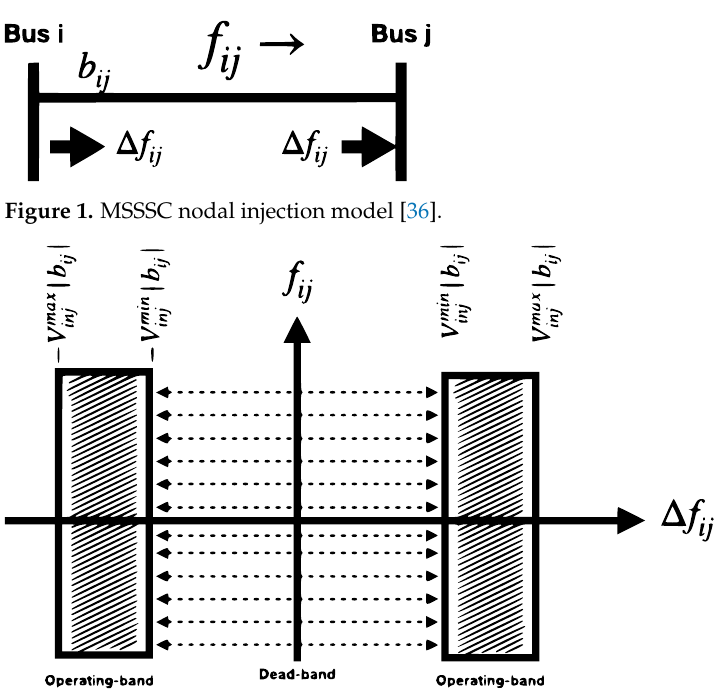
Figure 2. The operating and deadband range of MSSSC for voltage